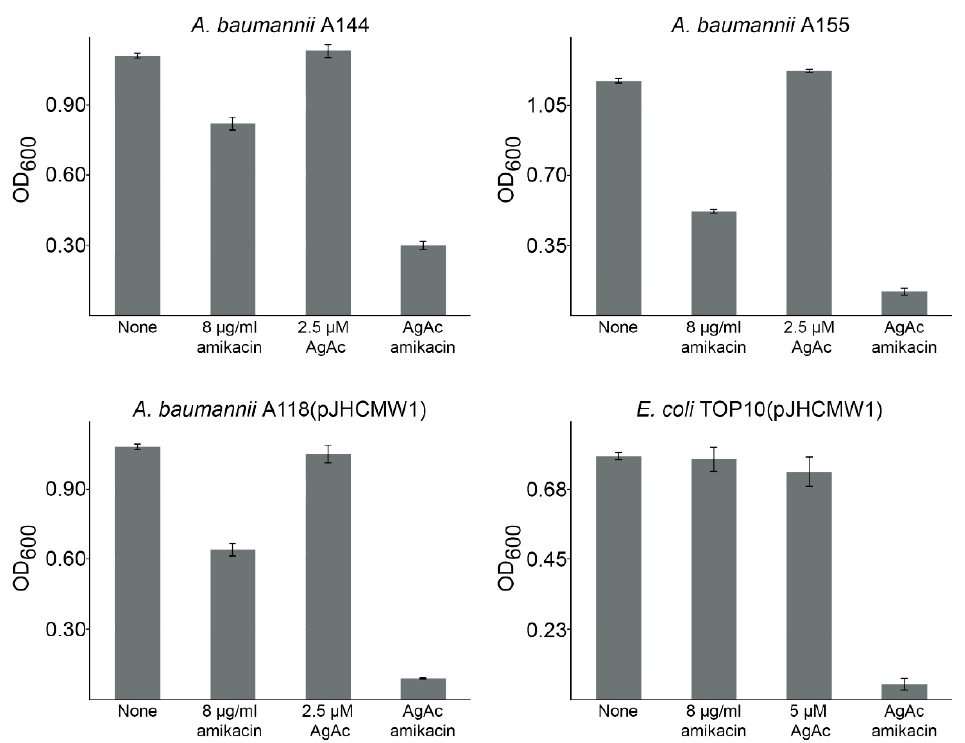
Figure 2. Effect of Ag 1+ on AAC(6 ′ )-Ib-mediated resistance to amikacin. A . baumannii A155, A144, and A118(pJHCMW1), and E. coli TOP10(pJHCMW1) were cultured in 100 μ L Mueller – Hinton broth in microtiter plates at 37 °C, with the additions indicated in the figure and the OD 600 was determined after 20 h. The concentrations when both compounds were added to the cultures are those used when they were added as single addition. P values of the cultures containing silver acetate (AgAc), and amikacin were calculated with respect to the results obtained in cultures containing only amikacin. All four p values were statistically significant (<0.05).